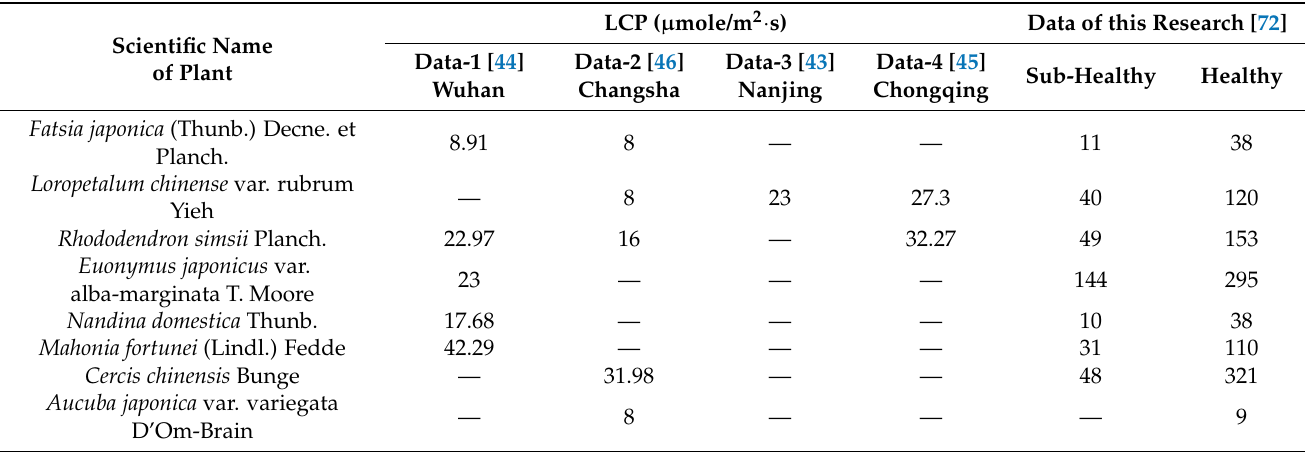
Table 5. Comparison between the results of our research and studies of other